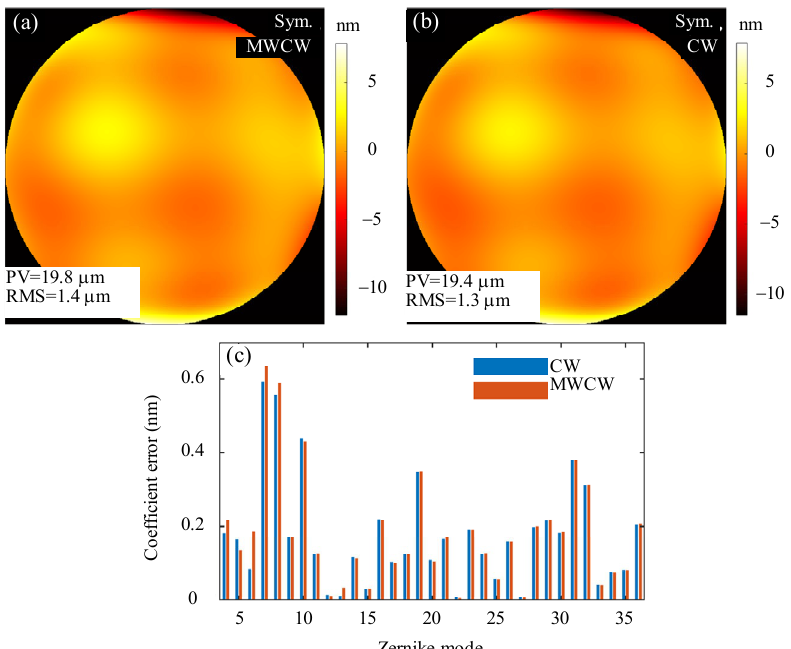
Fig. 3 Performance comparison of two methods when used for a symmetrical spectrum S (  ): wavefront errors obtained with (a) MWCW and (b) CW methods; (c) absolute values of Zernike coefficient errors.